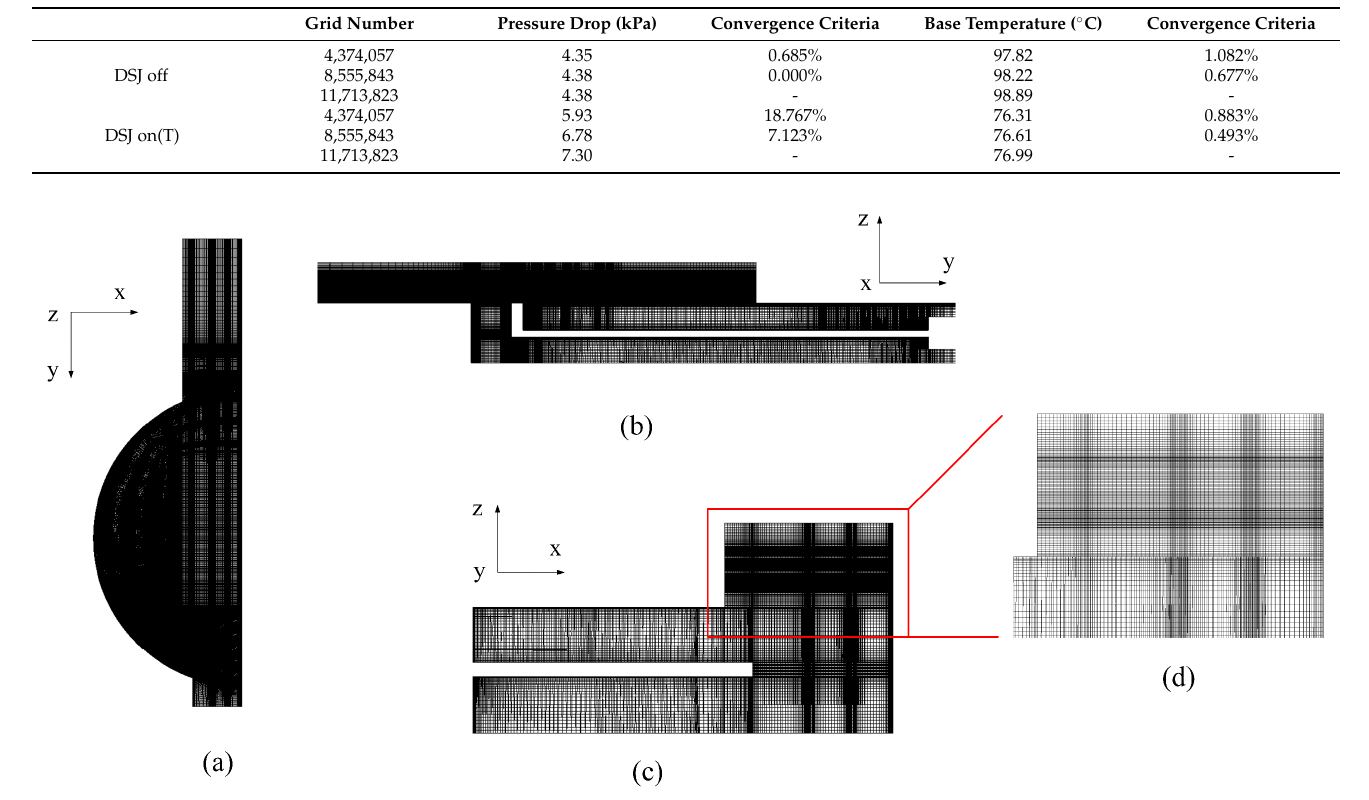
Figure 4. Structural grid of the model: ( a ) Vertical view; ( b ) Front view; ( c ) Side view; ( d ) Local details of ( c ). Table 1. Grid independence verification.